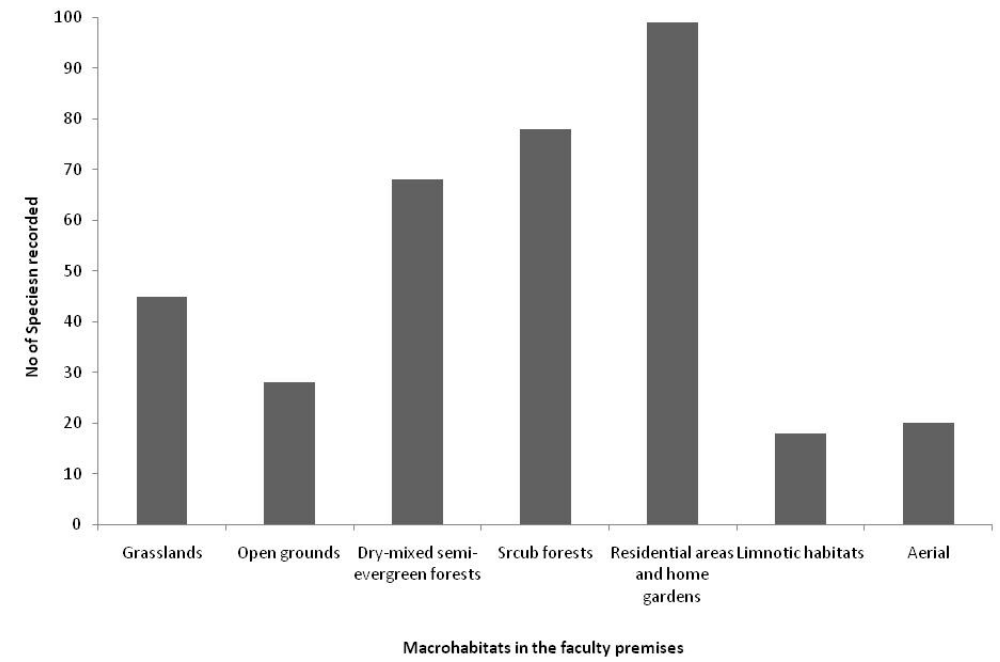
Figure 1. Number of bird species recorded from each habitat type in the Sabaragamuwa University